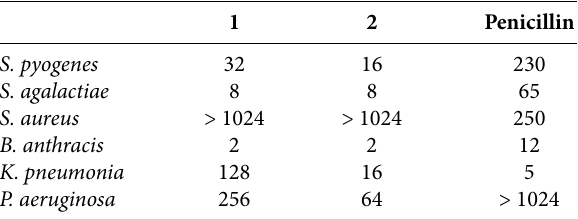
Table 5. Antimicrobial activities of the compounds as MIC values (μg/mL) 1